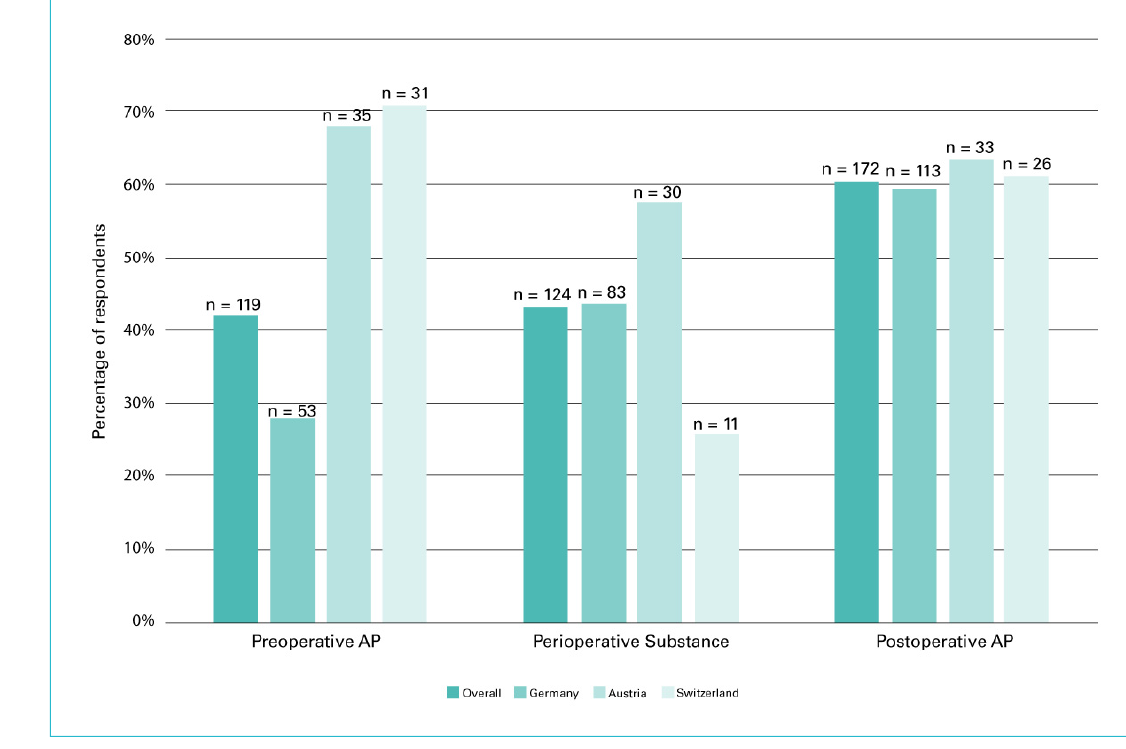
Figure 1: Nonadherence to the European Association of Urology (EAU) guidelines for pre-, peri- and postoperative antimicrobial pro- phylaxis (AP) in low-risk patients undergoing transurethral resection of the prostate; survey results (n = 286 urologists). Overall, 42% (119/286) of urologists routinely used preoperative antimicrobial prophylaxis, 43% (124/286) prescribed non-recommended perioperative pro- phylaxis agents, and 60% (172/286) routinely extended prophylaxis after surgery. In contrast to postoperative use, nonadherence rates for pre- and perioperative antimicrobial prophylaxis differed significantly between Germany, Austria and Switzerland (p = 0.853 vs p <0.001 and p = 0.007; chi-squared